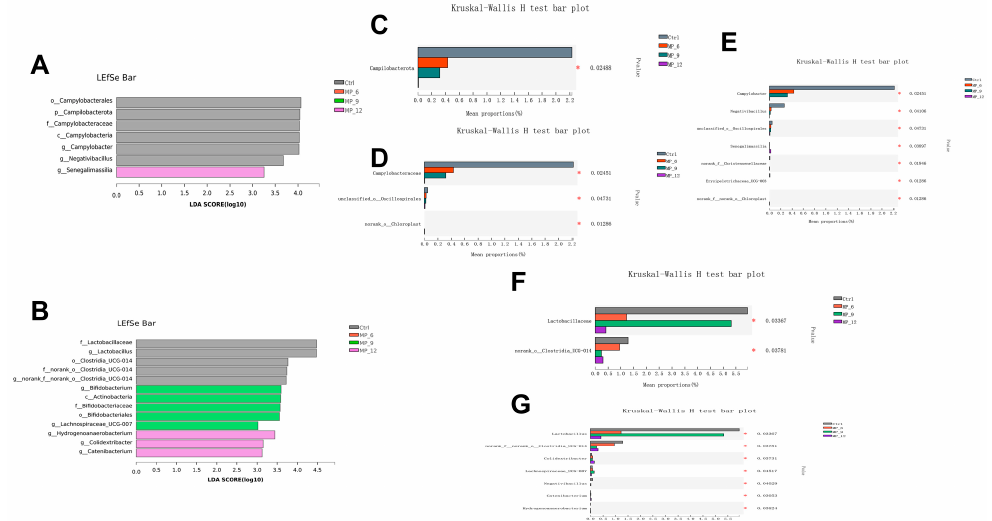
Figure 7. LEfSe analysis from phylum to genus level and histogram of hindgut microbial composition differences in finishing pigs dietary supplementation of mulberry leaf powder of varying